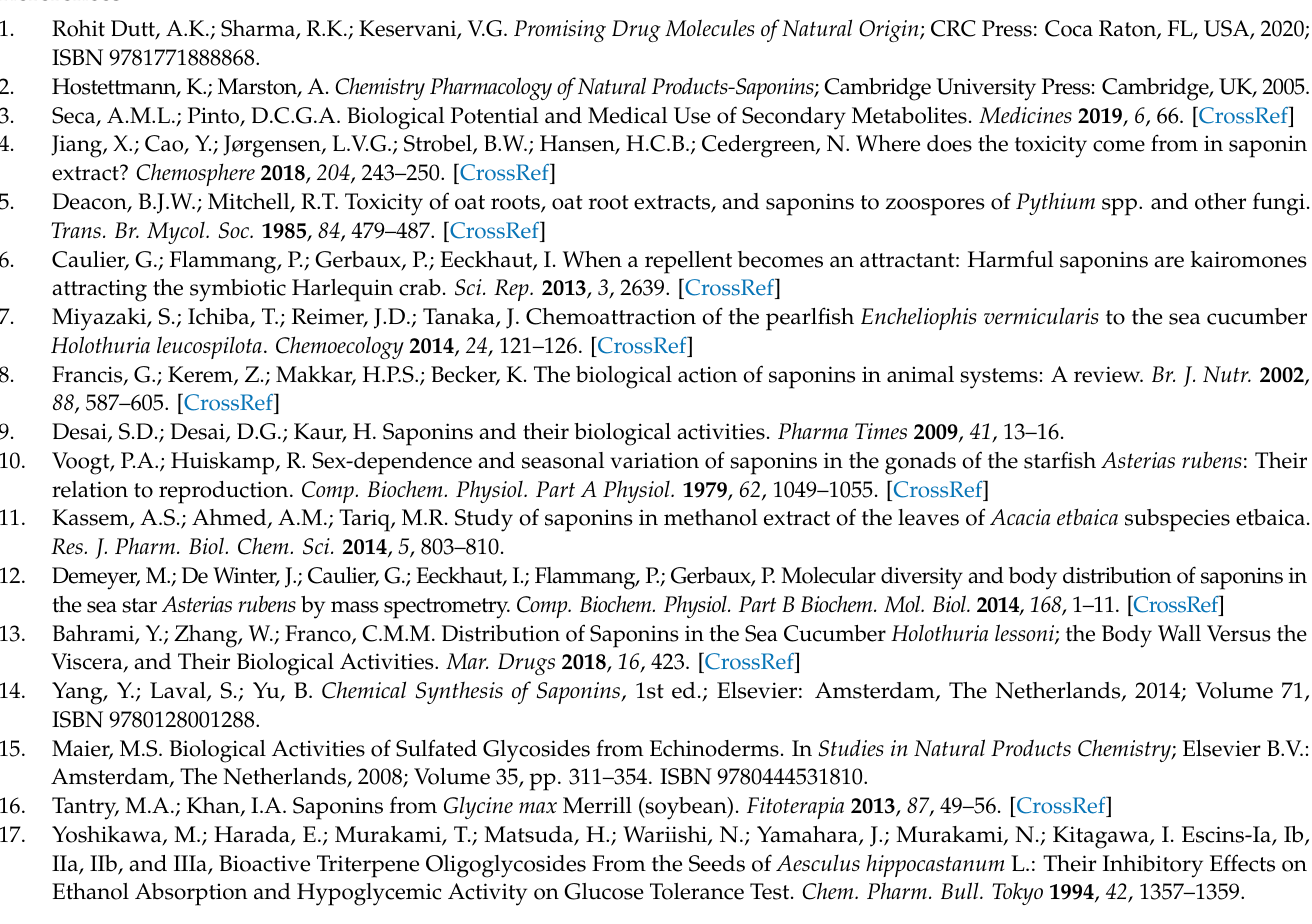
Figure S7: Methanolysis of the bidesmosidic saponins (from the natural extract—NE). All attempts under neutral/acidic conditions failed and only the transesterification using MeOK in anhydrous methanol under inert atmosphere afforded the expected C28-methylated